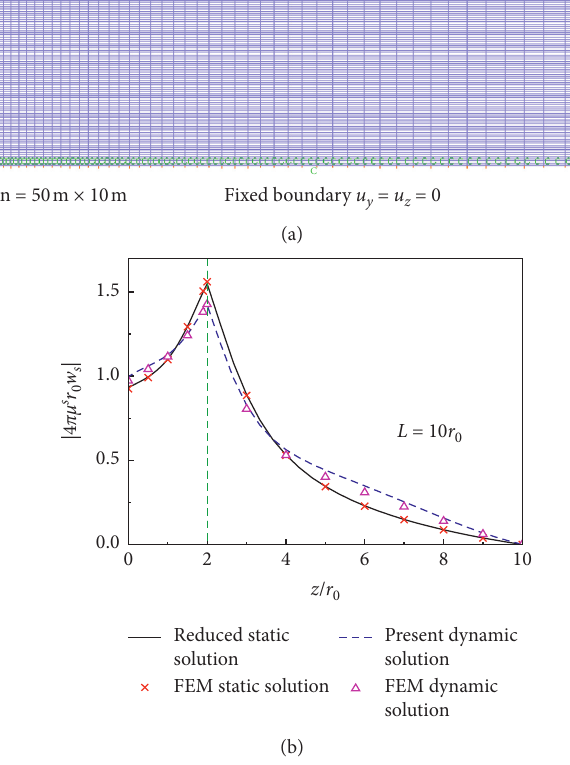
Figure 3: Comparisons of the present solution with the corresponding FEM solution: (a) axisymmetric finite element model by ADINA; (b) modulus of vertical displacement along with depth.